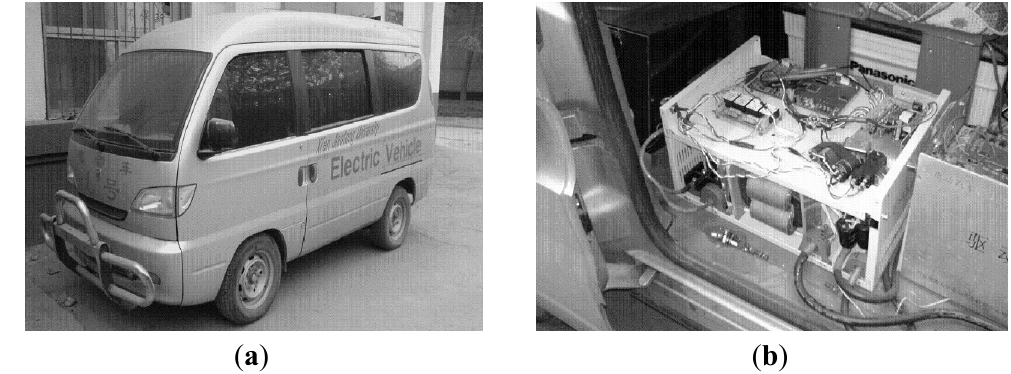
Figure 7. Hardware setup for experiments. ( a ) Electric vehicle; ( b ) controller for HPSS using DSP.